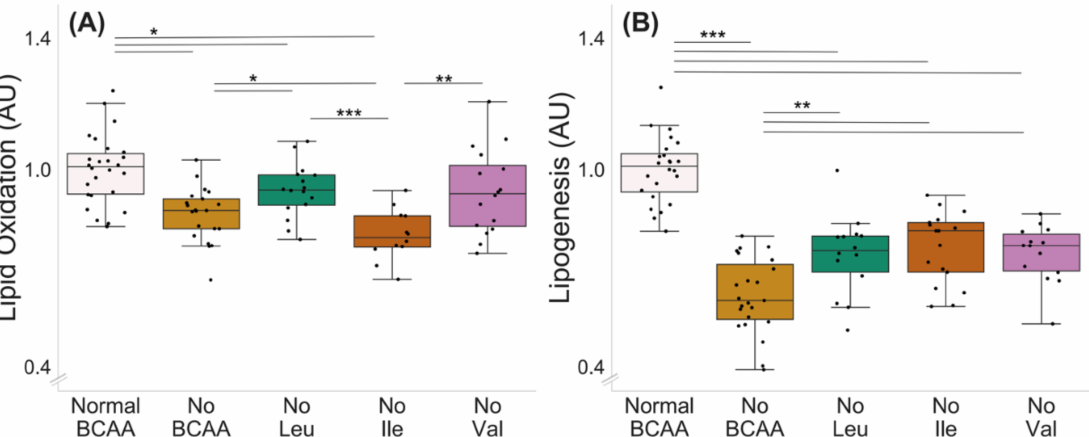
Figure 3. Lipid oxidation ( A ) and lipogenesis ( B ) with BCAA deprivation in murine C2C12 myotubes. ( A ) Deprivation of all BCAAs or deprivation of leucine or isoleucine alone reduced lipid oxidation in myotubes. Lipid oxidation was lower in isoleucine deprivation group compared with leucine and valine deprivation groups. Normal BCAA n = 26, no BCAA n = 21, no Leu n = 16, no Ile n = 12, no Val n = 16. ( B ) Deprivation of all BCAAs reduced lipogenesis in myotubes (normal BCAA vs. no BCAA). Deprivation of a single BCAA reduced lipogenesis compared with normal BCAA. Lipogenesis in single BCAA deprivation groups was higher compared with the no BCAA group. Normal BCAA n = 24, no BCAA n = 23, no Leu n = 14, no Ile n = 17, no Val n = 14. Boxes in the boxplot figures depict interquartile ranges and medians, and whiskers represent the 95% confidence interval. * p ≤ 0.050, ** p ≤ 0.010, *** p ≤ 0.001. BCAA = branched-chain amino acid, Leu = leucine, Ile = isoleucine, Val =